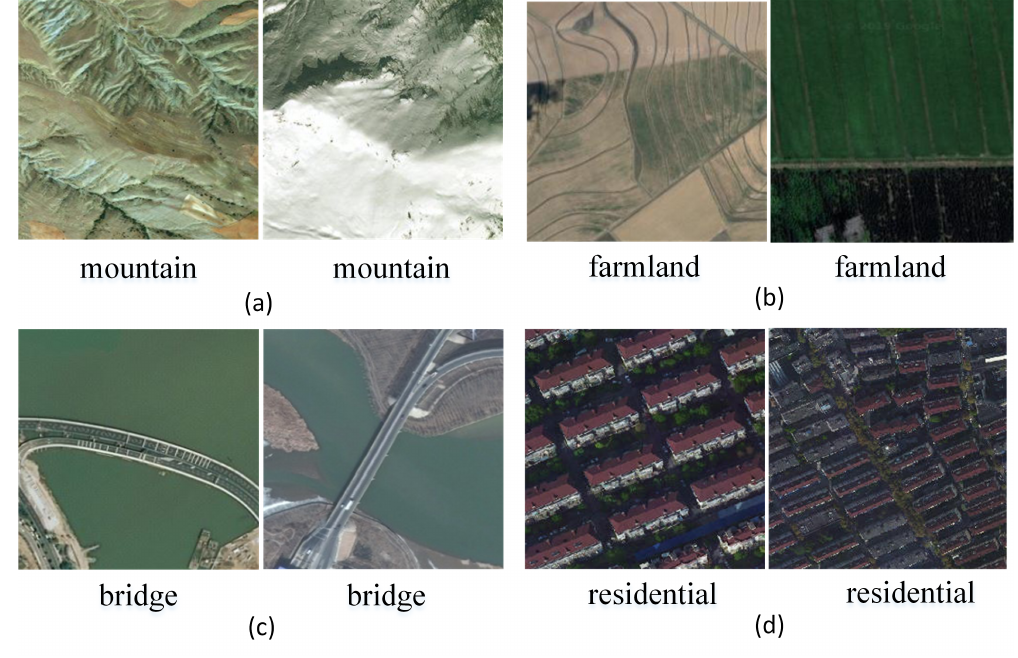
Figure 8. Higher intraclass diversity. ( a ) Instances of the same category in different seasons. ( b ) Instances of the same category in different climates and geographical environment. ( c ) Instances of the same category in different cultures and architectural styles. ( d ) Instances of the same category in different